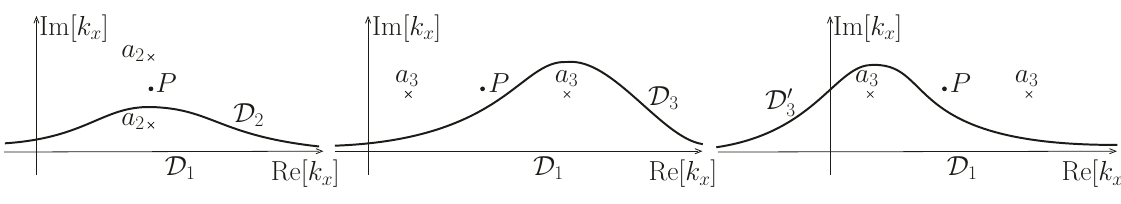
Figure 8 . Basic domain